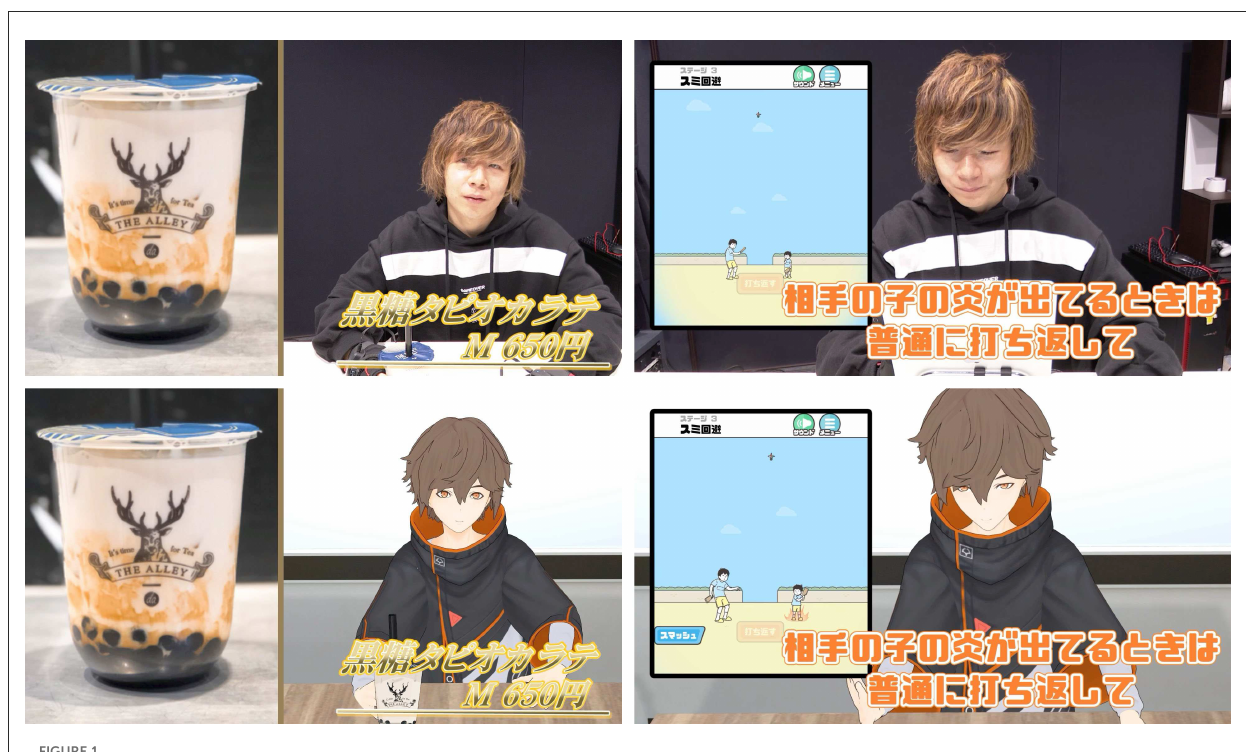
FIGURE1 Product promotional videos ( left : Tapioca drink; right : Game